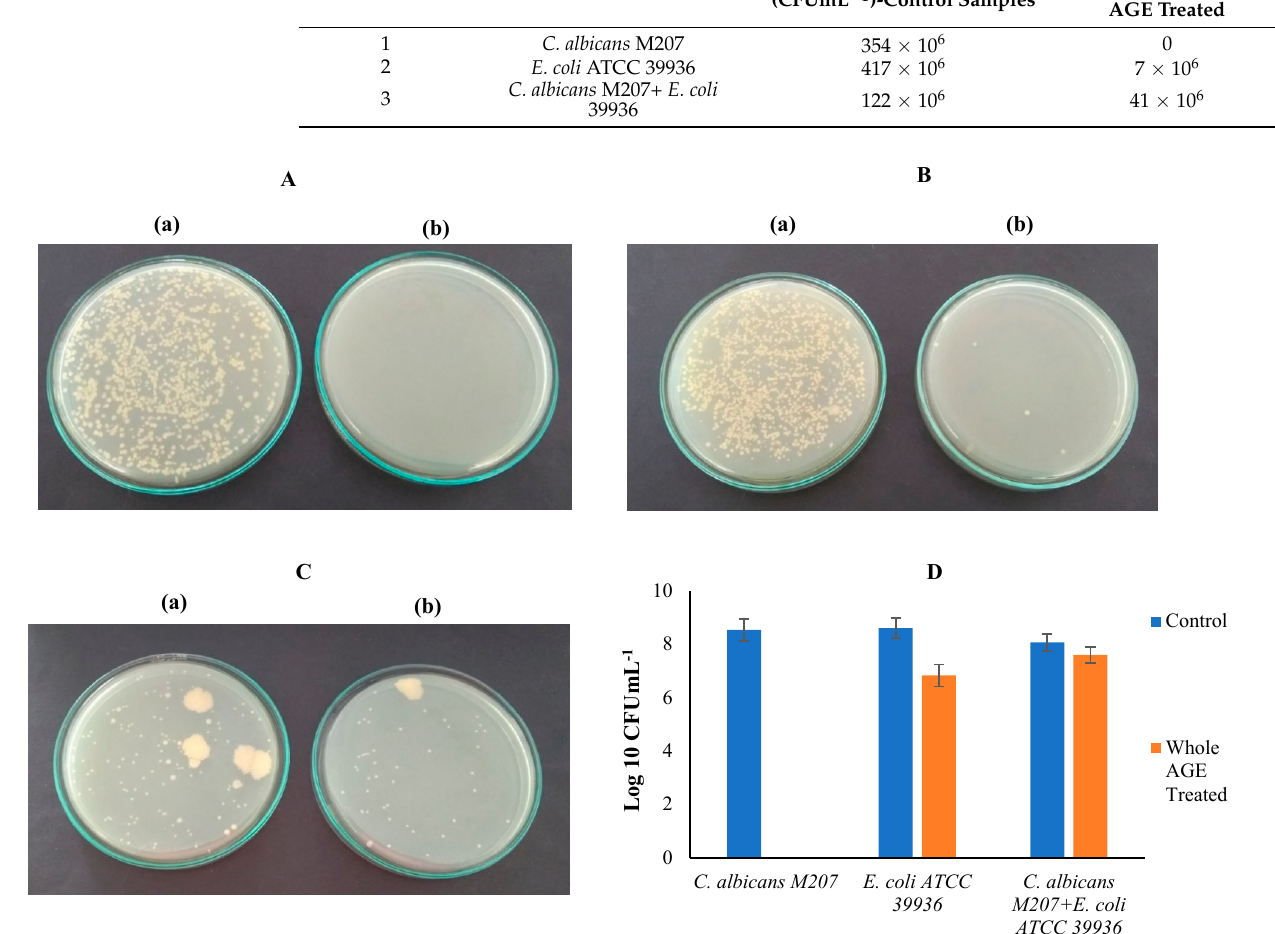
Figure 4. ( A ) CFU for C. albicans M-207 at 24 h: ( a ) Control; ( b ) Whole AGE Treated (1 mg). ( B ) CFU for E. coli ATCC 39936 at 24 h: ( a ) Control; ( b ) Whole AGE Treated (1.25 mg). ( C ) CFU for C. albicans M207+ E. coli ATCC 39936 at 24 h: ( a ) Control; ( b ) Whole AGE Treated (1.25 mg). ( D ) Log 10 CFUmL − 1 for C. albicans M-207, E. coli ATCC 39936, C. albicans M207+ E. coli ATCC 39936 at 24 h. The absence of bar for C. albicans M207 whole AGE-treated sample indicates complete inhibition and therefore no colonies on the plate and n = 3. All values are expressed as mean and standard deviation.